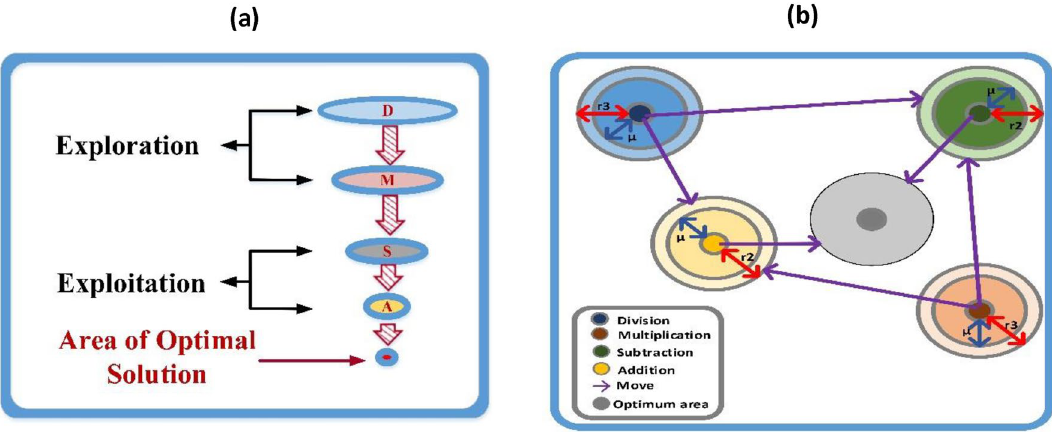
Figure 5. ( a ) Hierarchy of arithmetic operators, ( b ) Model for changing arithmetic operators’ positions in AOA toward the optimal